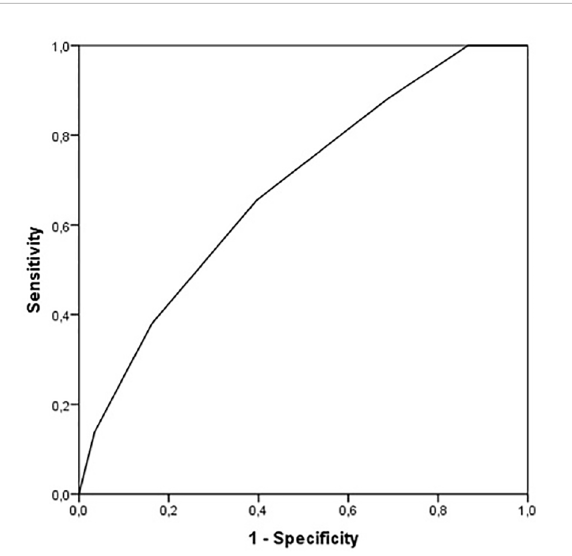
FIGURE 4 Receiver operating characteristic curve of CSA-CKD score for MAKE. MAKE, major adverse kidney